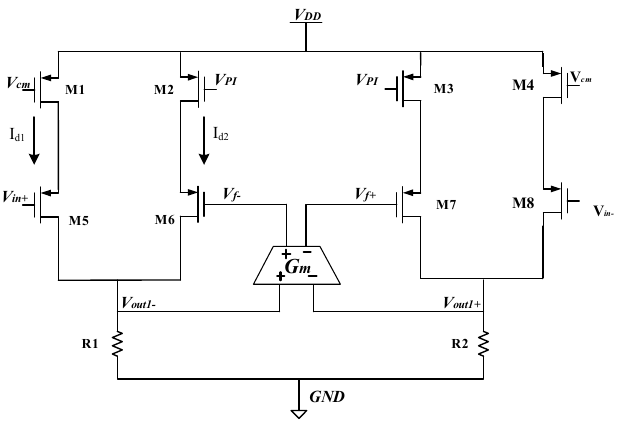
VREF Figure 12. Circuit schematic diagram of the PI controller.